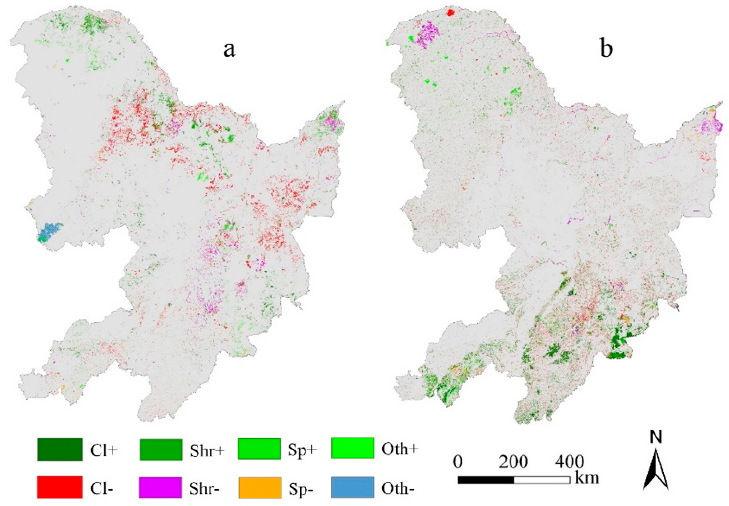
Figure 7. Expansion and decline of forest land area ( a ) represents 1980–2000, ( b ) represents 2000–2020.